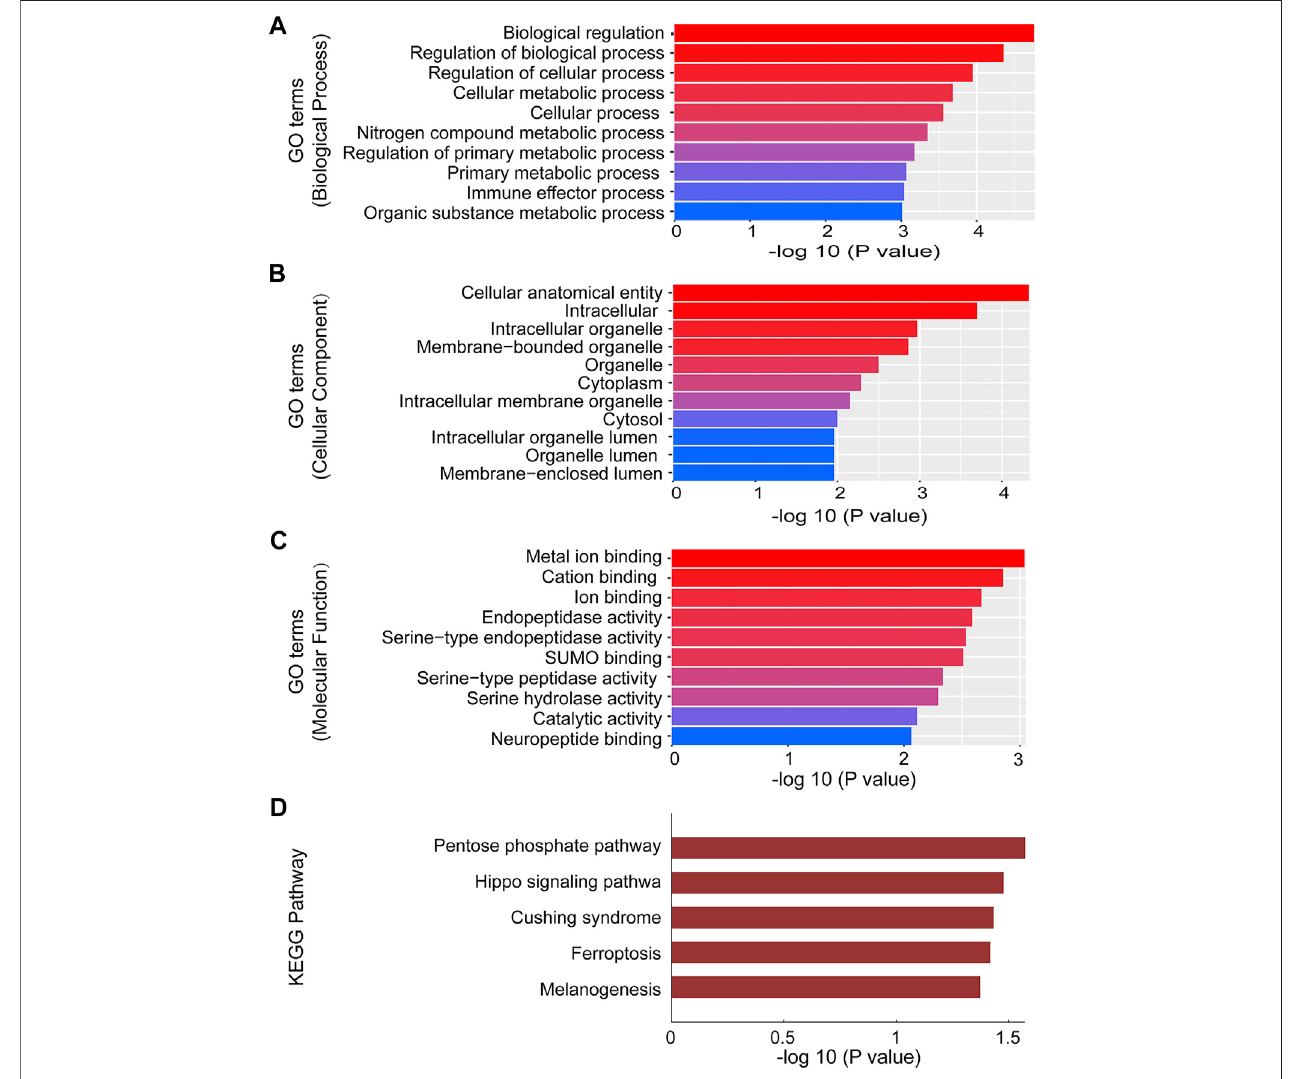
FIGURE4| GOand Pathway analysisofmmu_circRNA_014309 and 21856. (A) Top10GOterms inBP. (B) Top10GOterms inCC. (C) Top10GOterms inMF. (D) Top 6 enrichment pathways. GO, Gene Ontology; CC, cellular components; BP, biological processes; MF, molecular functions.